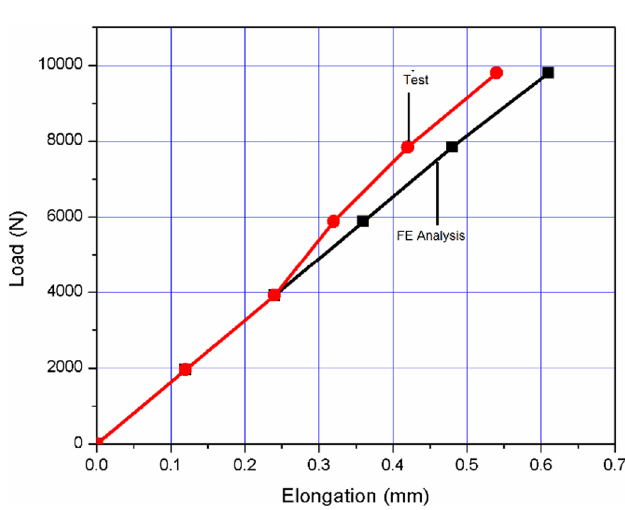
Fig. 11. Elongation behaviors of skeleton.